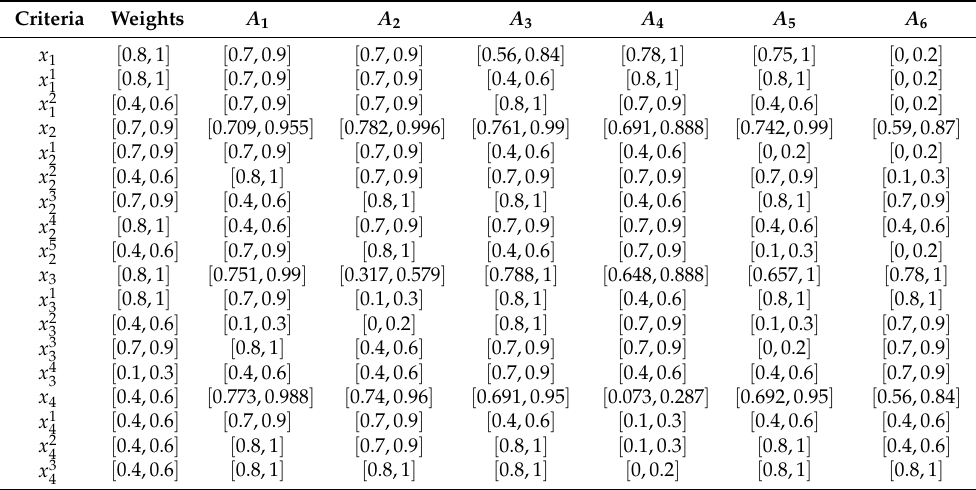
Table 10. The evaluation value of primary criteria for α = 0 with respect to the cabinet frame.